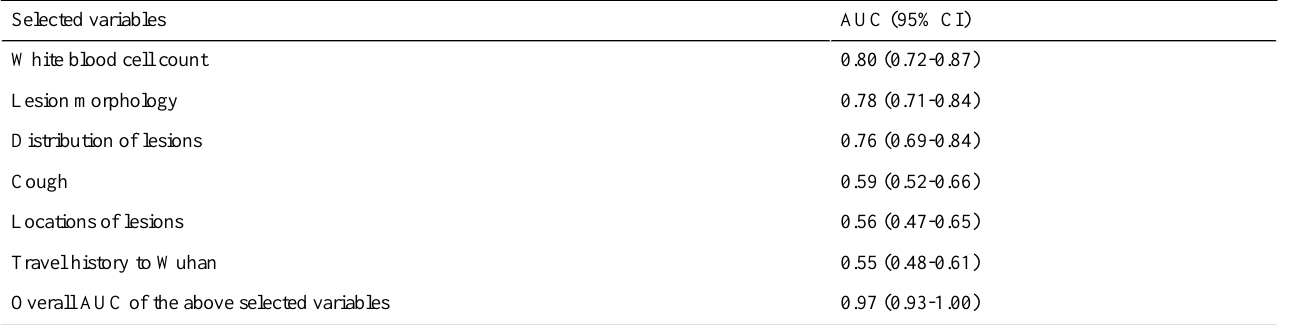
Table 4. Area under the curve (AUC) values for the selected predictors from the logistic model with LASSO (least absolute shrinkage and selection operator) selection.